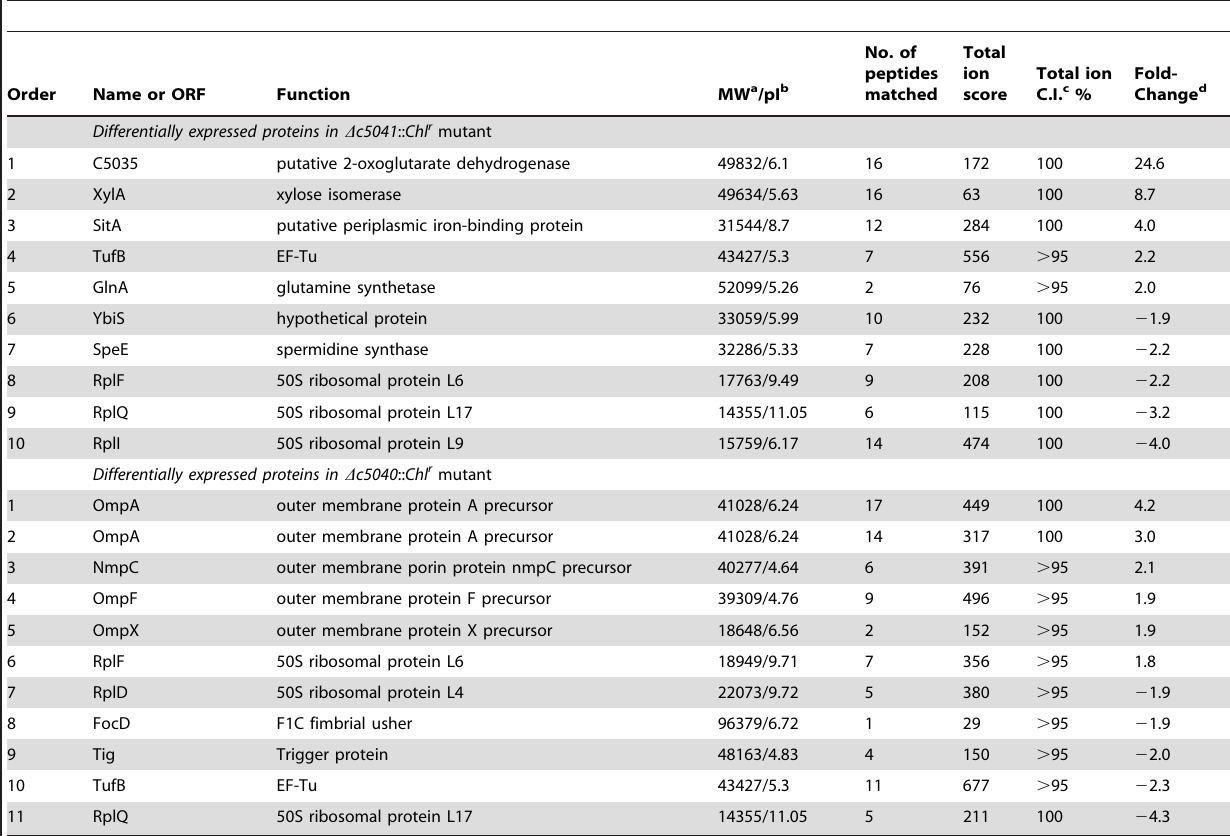
Table 1. Differentially expressed proteins identified in mutant strains of UPEC CFT073 as compared to the wild-type when cultured in human urine.